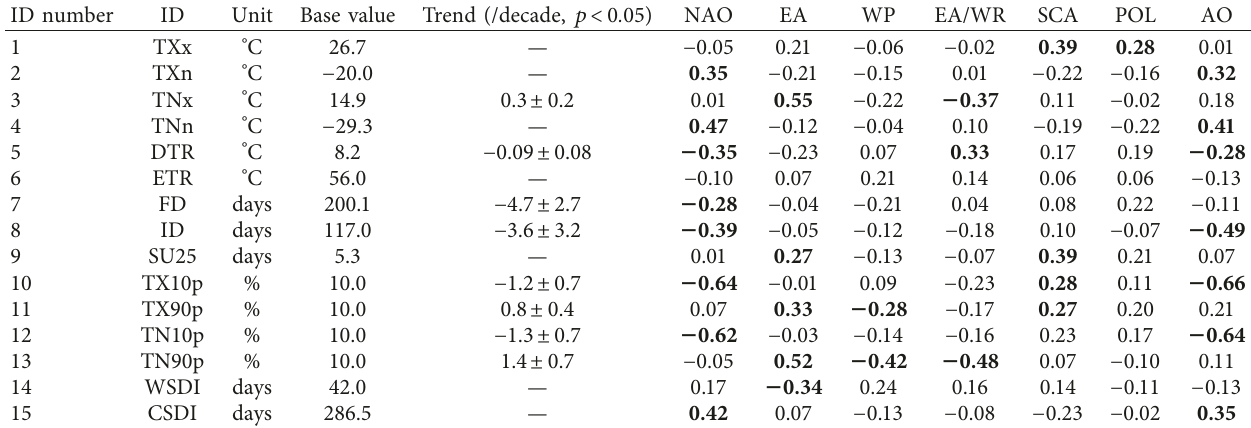
Table 3: Base value (average during 1961–2011), statistically significant ( p < 0 . 05) trends, and Spearman rank correlation ( ρ ) with NHTPs for daily extreme temperature indices given in Table